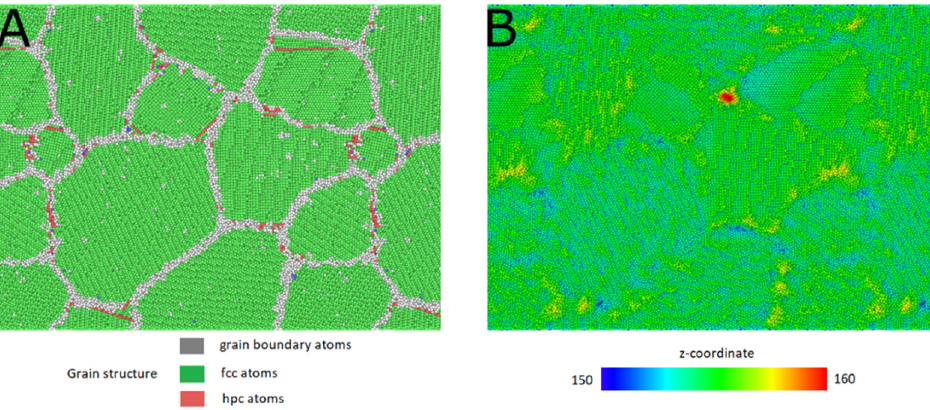
Figure 3. ( A ) Grain structure underlying the surface. Atoms are colored by PTM structure type – green: fcc atoms, grey – grain boundary atoms, red: hcp atoms (atoms part of a stacking fault). ( B ) Height map of the surface in the case of critical surface deformation. Atoms are colored by the z-coordinate. Surface protrusion has formed above a quadruple junction.